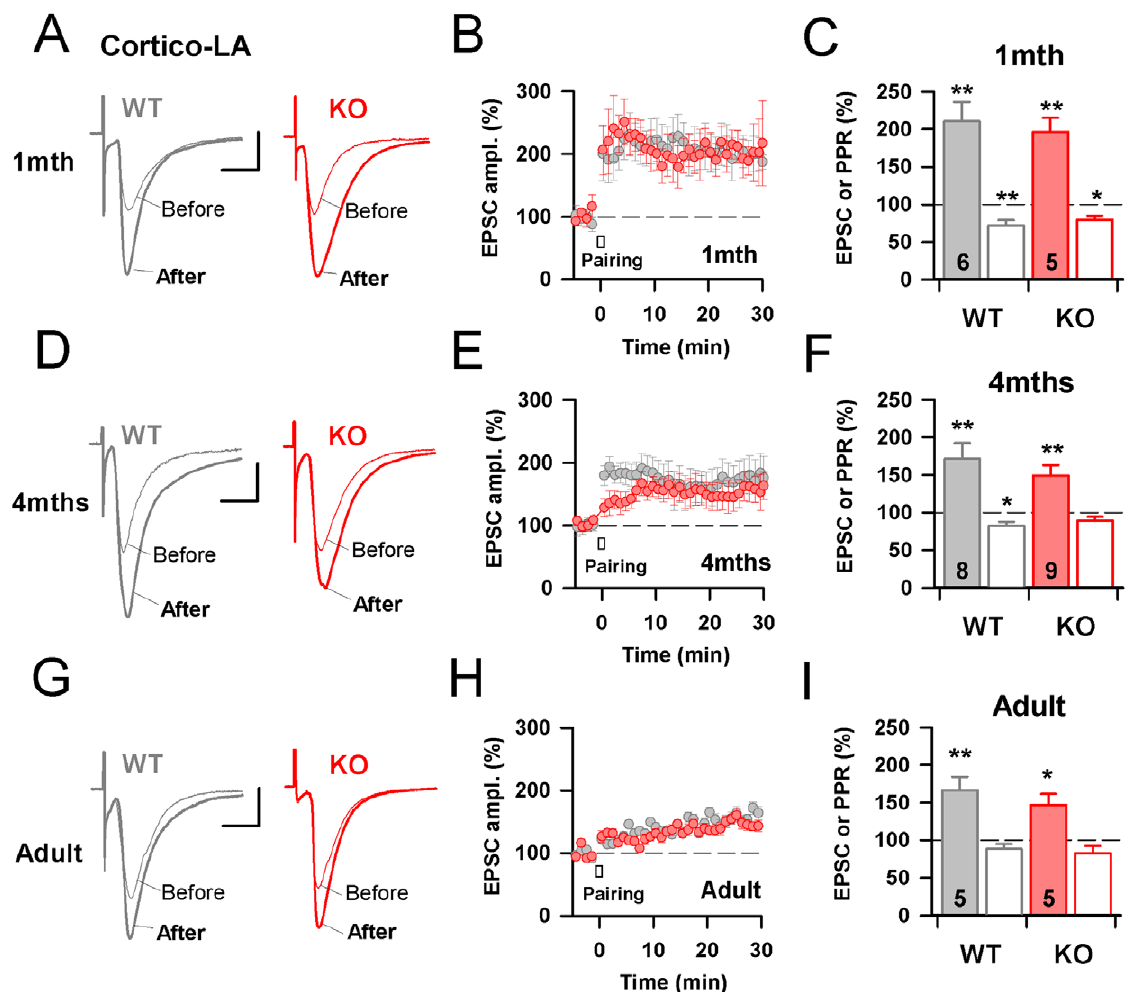
Figure 3. Intact associative LTP at Cortico-LA synapses in early and late symptomatic Mecp2308/Y mutant mice. A: Typical EPSCs obtained in juvenile WT (grey) and KO (red) mice before and after pairing (see material and methods section). Scale bars: 50 pA and 10 msec. B: Mecp2 is not necessary for presynaptic LTP in juvenile mice. C: Bar graphs summarizing the evolution of the EPSC (filled bars) and PPR (empty bars) in WT (grey) and KO (red) mice. The number of recorded cells is indicated. *: p , 0.05, **: p , 0.01. D–F: Same presentation as in A–C, but for 4 months old WT and KO animals. G–I: Same presentation as in A–C, but for adult ( . 6 months) WT and KO animals.